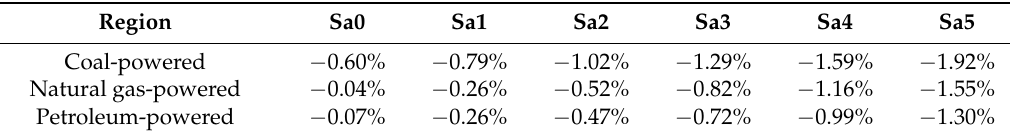
Table 7. Fossil fuel power generation output changes.